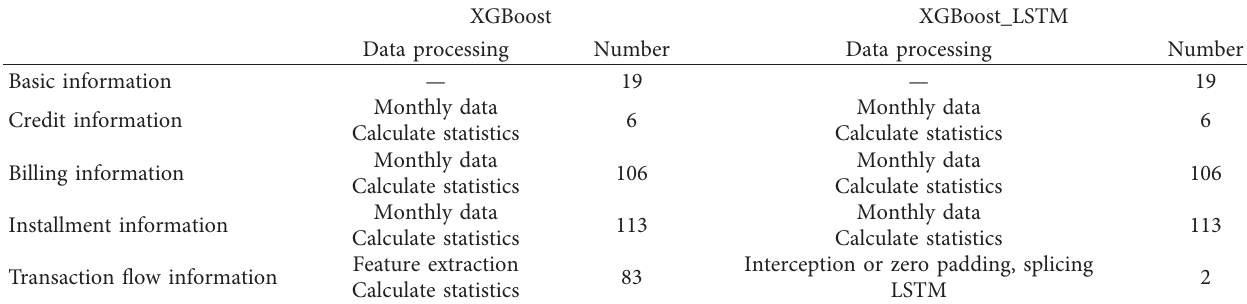
Figure 8: The confusion matrix and ROC of the XGBoost-LSTM model. (a) The confusion matrix of the test data. (b) The ROC curve of the test data. Table 7: Data processing methods for modeling with different algorithms.